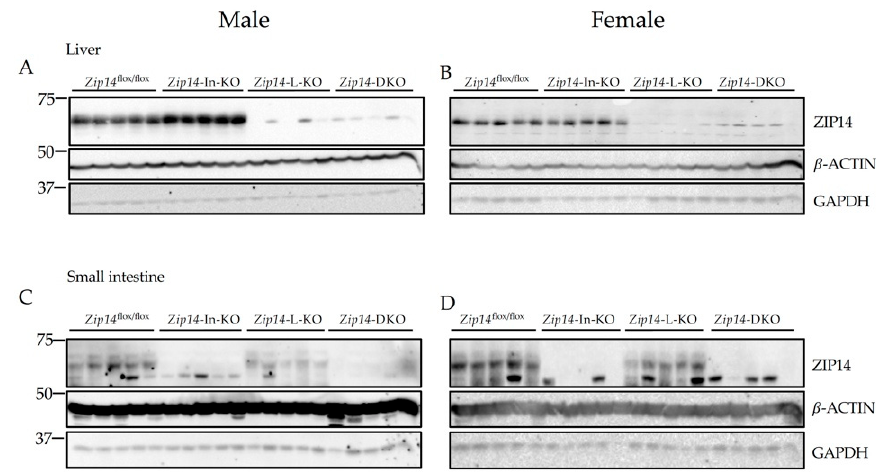
Figure 1. Western blot analyses to confirm tissue-specific Zip14 knockout in mice. Zip14 flox/flox mice were bred with tissue-specific Cre transgenic mice to generate mice with Zip14 knockout in the intestine, the liver, or in both tissues. Mice were sacrificed and tissues were collected at 9 weeks of age. Western blot images of ( A , B ) the liver and ( C , D ) small intestine samples from control ( Zip14 flox/flox ), intestine-specific Zip14 KO ( Zip14 -In-KO), liver-specific Zip14 KO ( Zip14 -L-KO), and (intestine and liver)-specific Zip14 KO ( Zip14 -DKO) mice ( A , C : male mice; B , D : female mice, n = 5). Both β -ACTIN and GAPDH were used as loading controls.